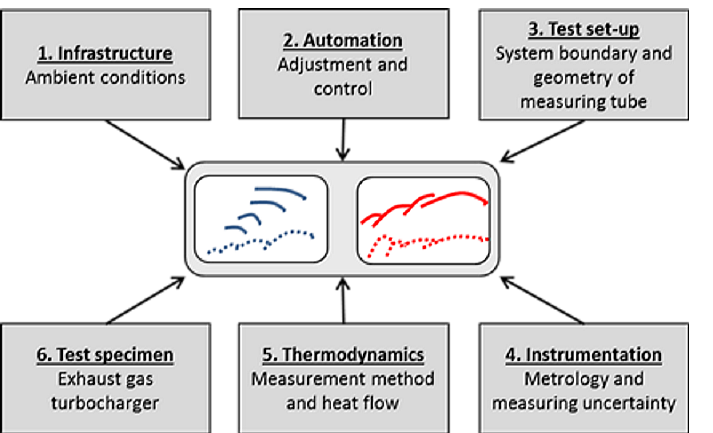
Figure 6. Factors of influence of a turbocharger on a hot gas test bench by generating characterizing maps, based on